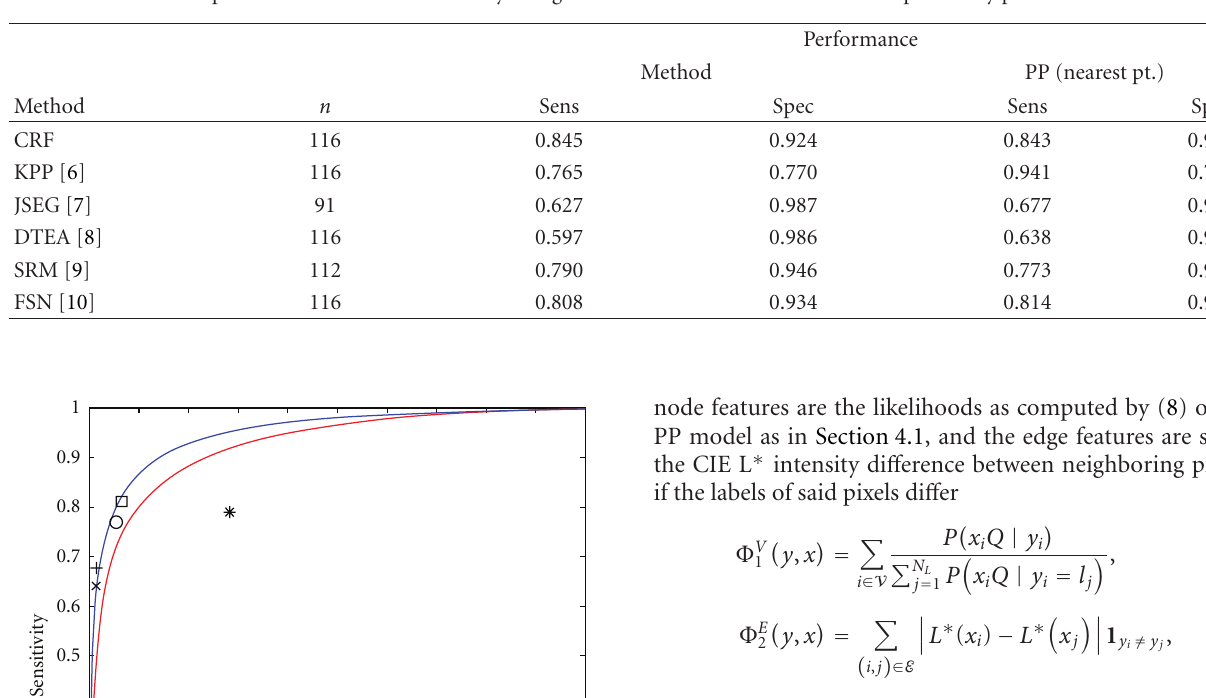
Table 1: Comparison of our PP model’s ability to segment lesions to our CRF model and 5 previously published methods.